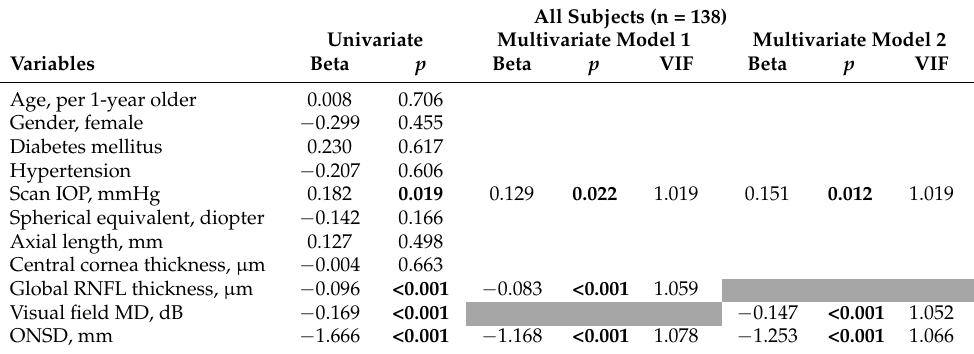
Table 3. Factors associated with LCCI in all